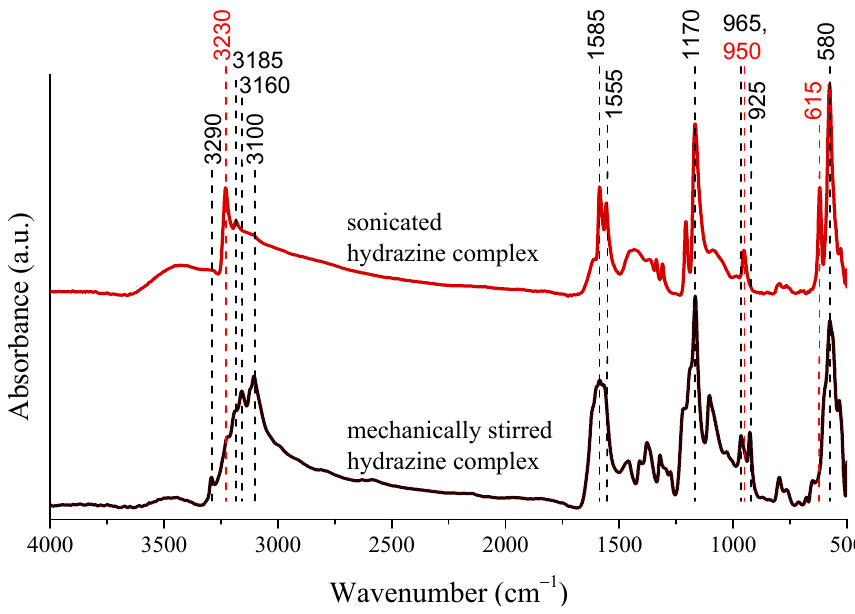
Figure 2. Infrared spectra of the nickel − hydrazine − iodide complexes formed on mechanical stirring or sonication (30 W output power and continuous emission) for 4 h at 75 °C.